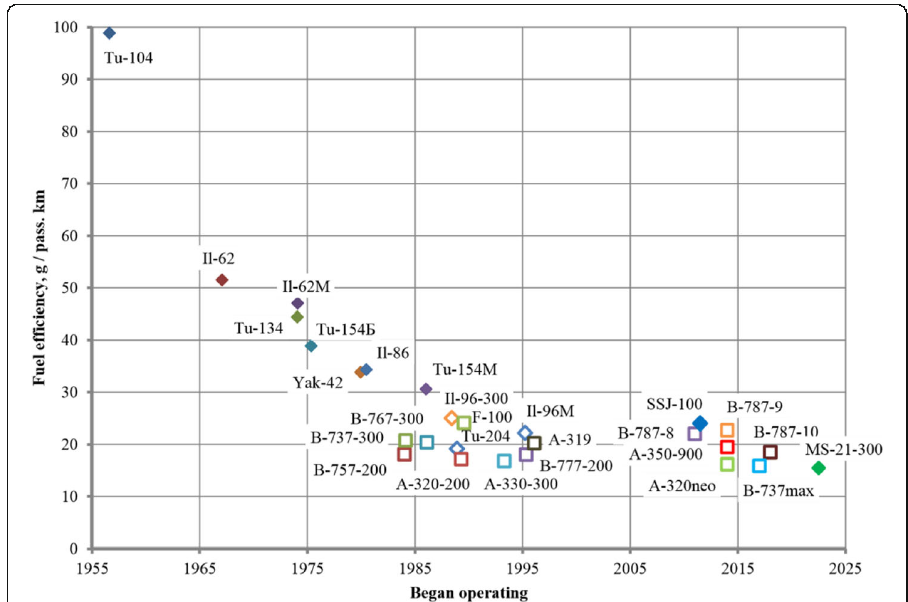
Fig. 1 Change of route aircraft fuel efficiency with time